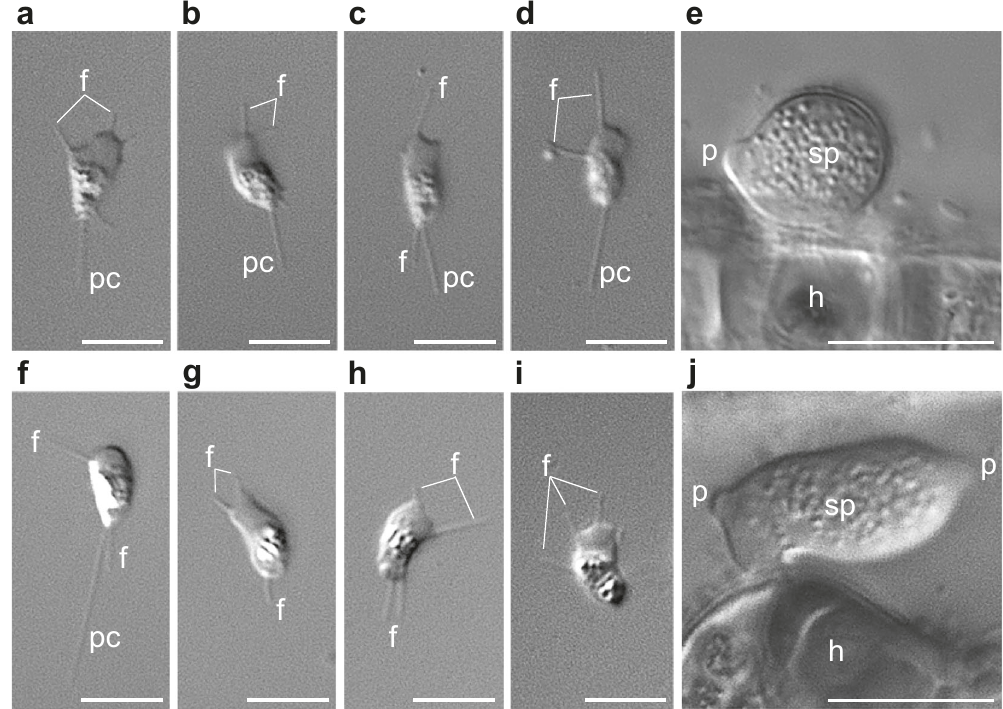
Fig. 1 Light microscopy observations of sanchytrid cells. a – e Life cycle stages of Sanchytrium tribonematis . f – j Life cycle stages of Amoeboradix gromovi . a – d , f – i Amoeboid crawling zoospores with fi lopodia (f) and posterior pseudocilium (pc). g – i Zoospores with retracted pseudocilium. e , j Sporangium (sp) with one ( e ) or two ( j ) papillae (p) on the host (h) surface. Scale bars: a – d , f – i , 5 µ m; e , j , 10 µ